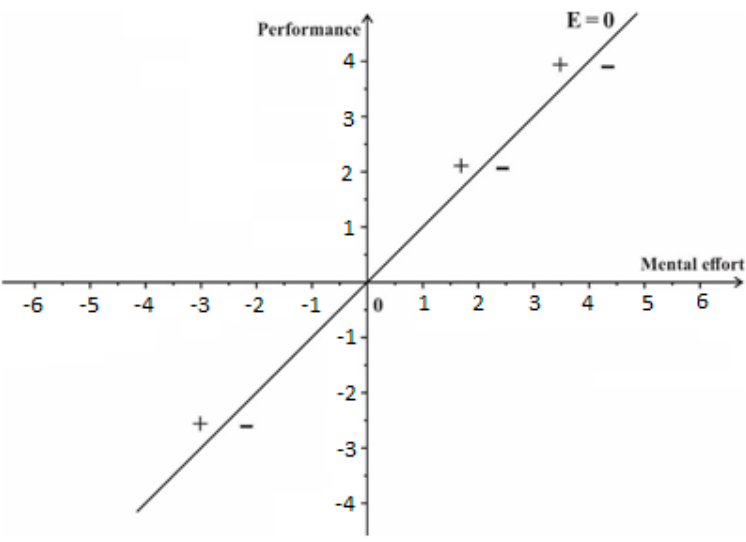
Figure 1. Graphical representation of instructional efficiency (adapted according to [17]).